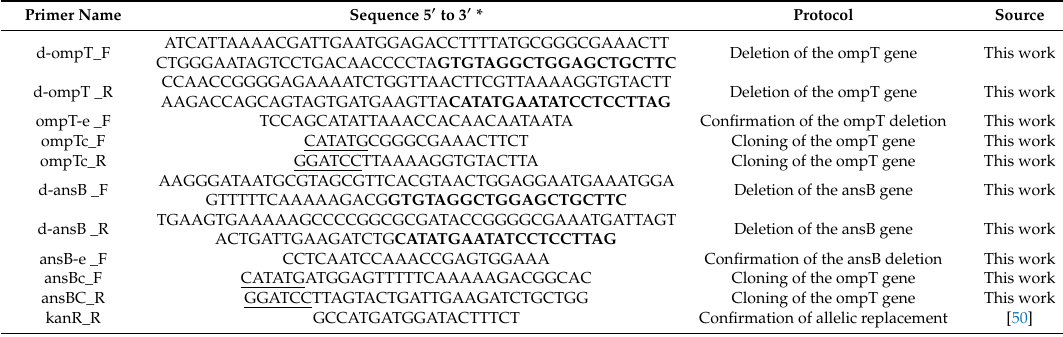
Table 1. Primers used in this